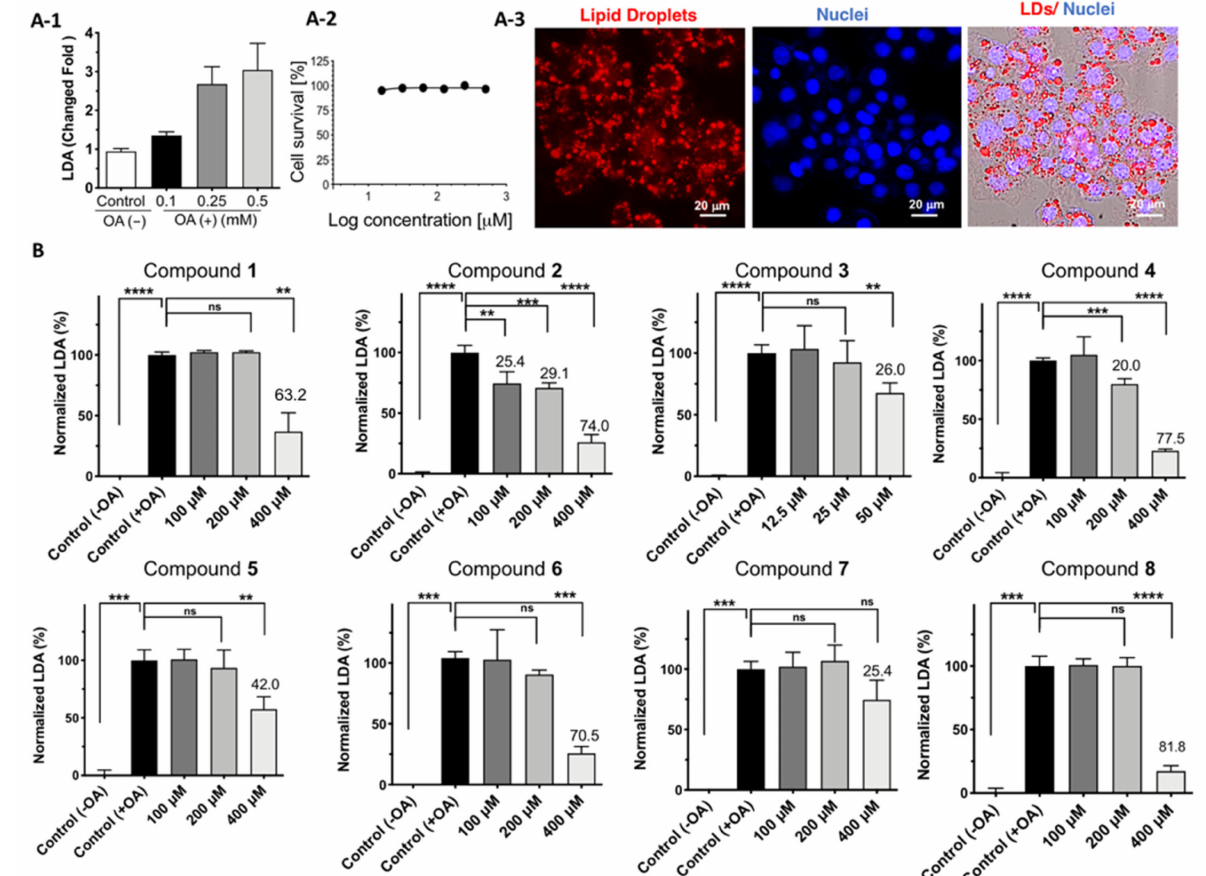
Figure 4. ( A ) Lipid droplet accumulation (LDA). A-1: LDA induced by 0.1, 0.25, and 0.5 mM oleic acid in HepG2 cells; A-2: Cell survival with oleic acid (0.25 mM); A-3: Cell survival with oleic acid (0.25 mM); ( B ) LDA inhibition (LDAI) activity of 1 – 8 in HepG2 cells. Graph showing the mean values of the LDAI (four replications). **** p < 0.0001, *** p < 0.001, ** p < 0.01 when compared with the untreated control (+OA) group. ns: not